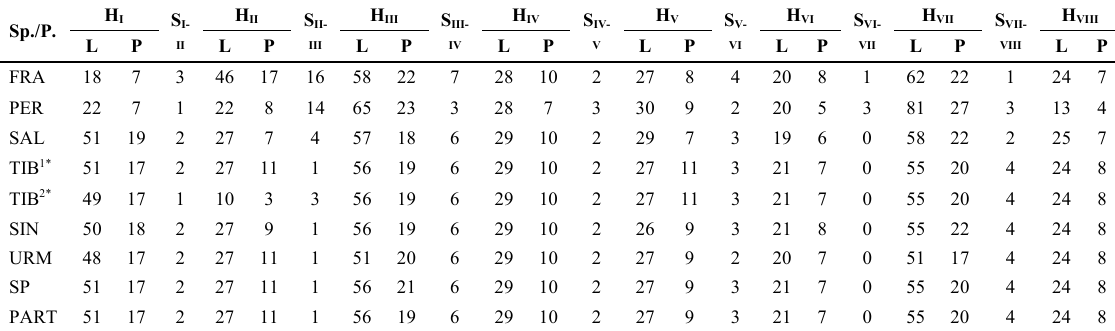
Table 2. A statistic for the composition of the secondary structures proposed in this study. Data shown as number of nucleotides (L and S) or number of Nucleotide pairs (P). H x : The xth helix; L: Length; P: Paired nucleotides; S x-y : Single strand between the xth and yth helix. Abbreviations of species/populations are defined in Table S1.